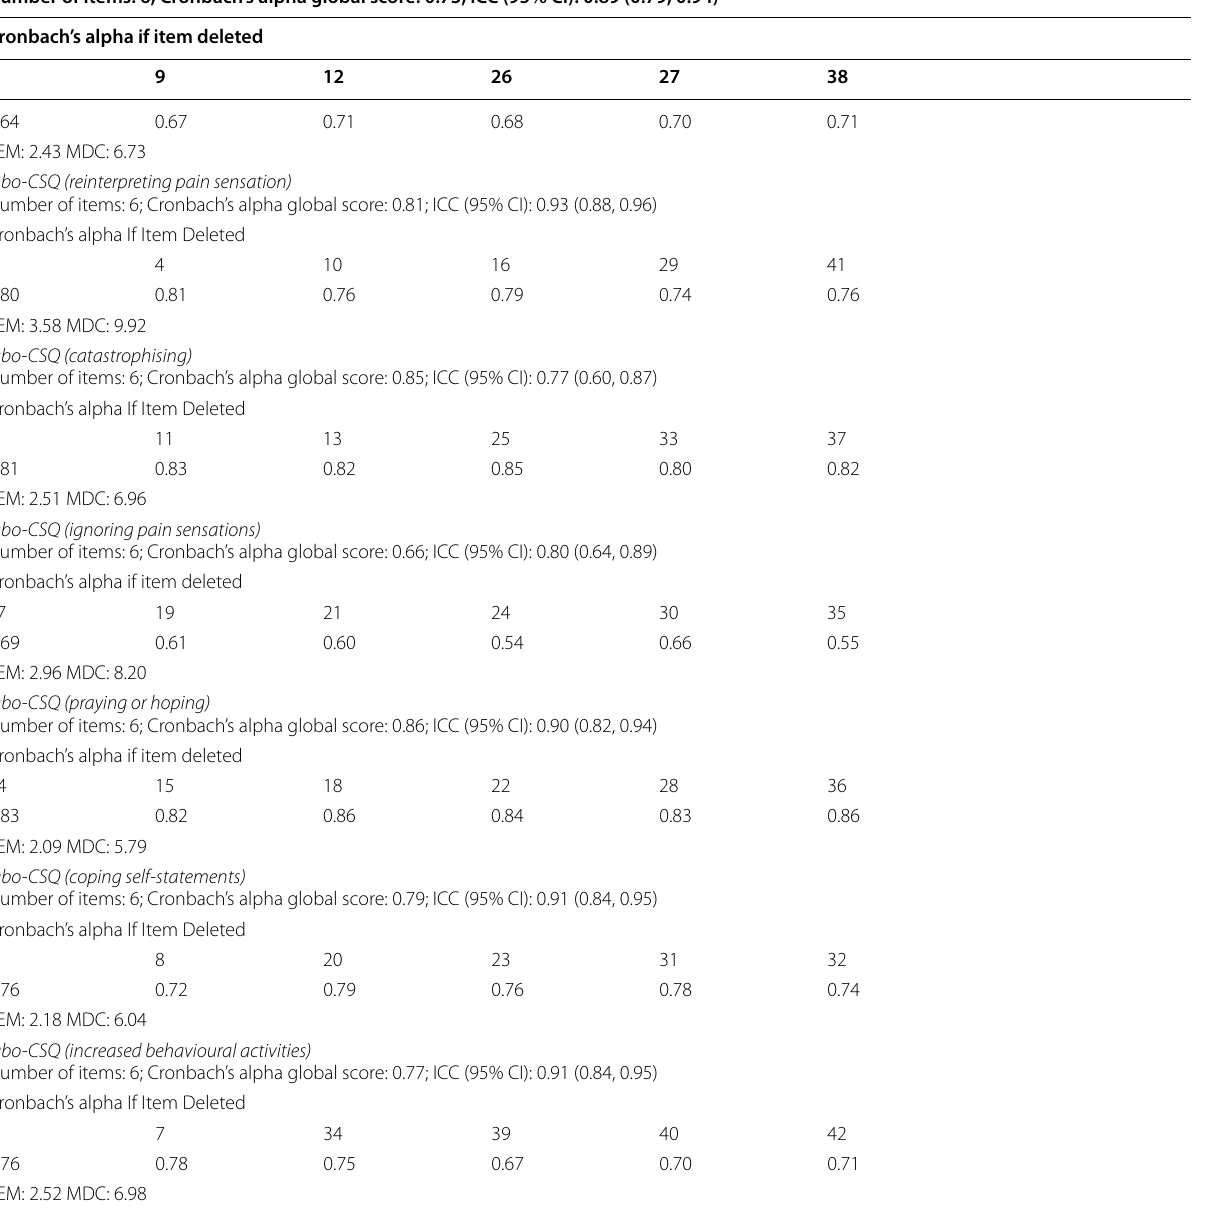
Table 2 Reliability of Igbo‑CSQ Igbo‑CSQ (diverting attention) Number of items: 6; Cronbach’s alpha global score: 0.73; ICC (95% CI): 0.89 (0.79,